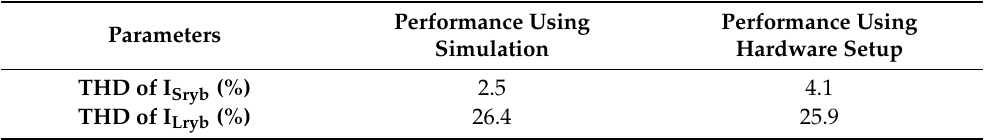
Figure 13. Supply currents of 3 phases. Table 4. THD of simulated and experimented models.